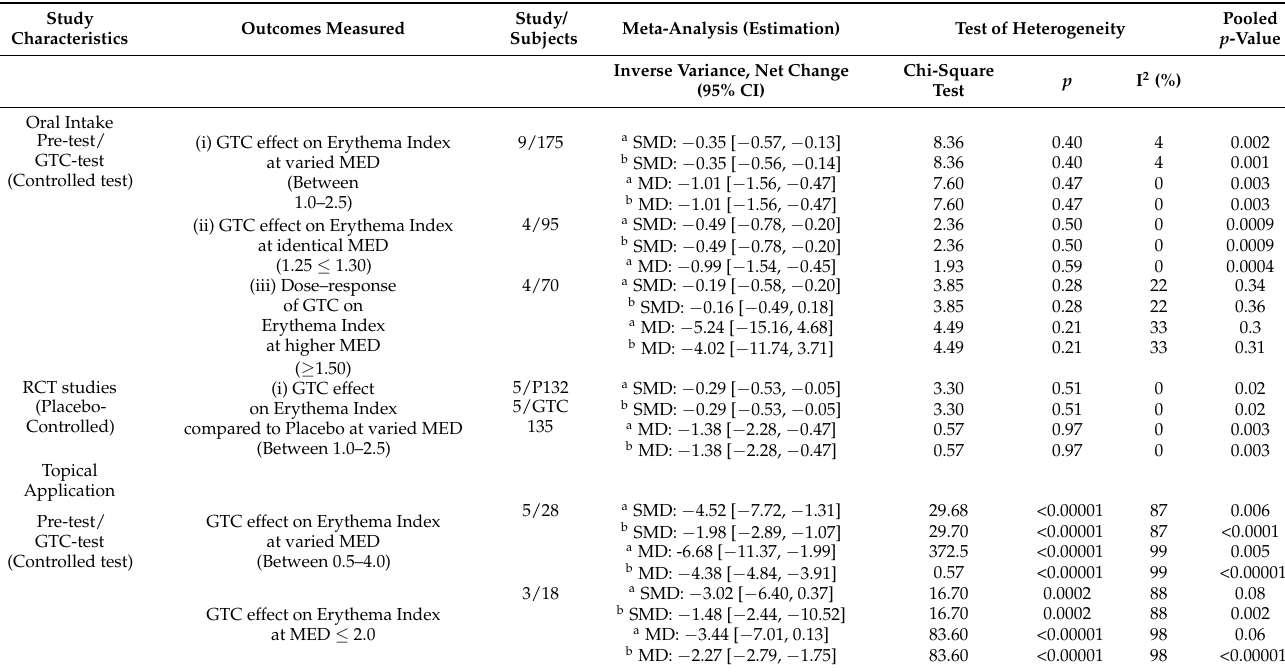
Table 3. A meta-analysis of included studies investigating the effect of green tea catechin supplementation on the ultraviolet irradiation-induced erythema response in humans ranked by selected study